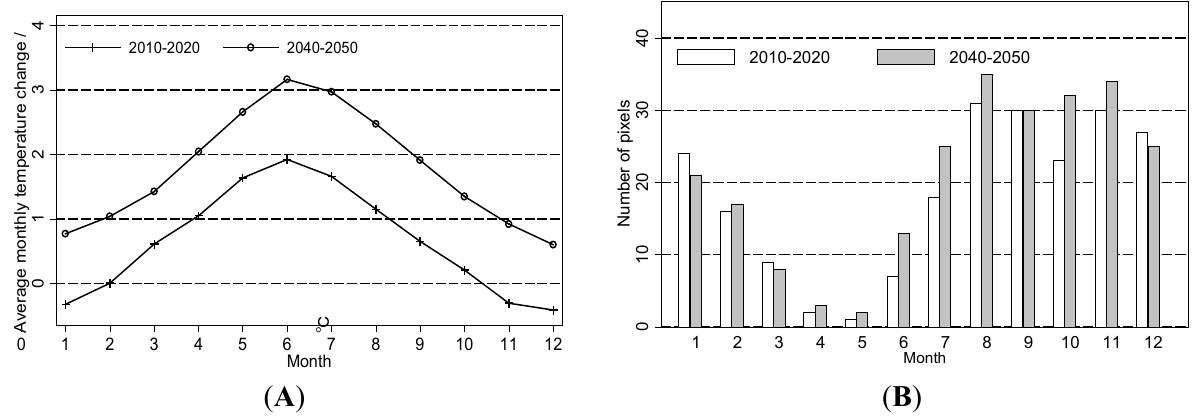
Figure 6. Effects of future urbanization on average monthly temperature in Northeast megalopolis, USA: ( A ) average monthly temperature changes in urban area; ( B) number of pixels in nonurban area with average monthly temperature change exceeding 0.5